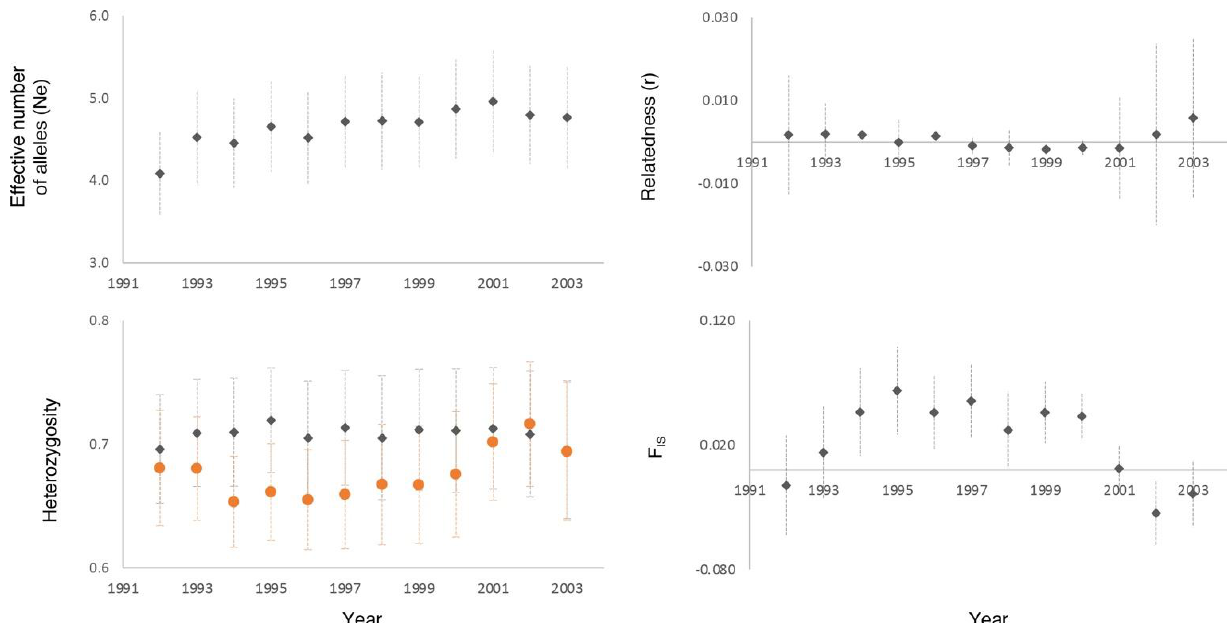
Figure 2. Genetic diversity over time, based on 17 microsatellite loci. The effective number of alleles ( Ne , top-left panel), observed heterozygosity ( H O , bottom-left panel, orange circles) and expected heterozygosity ( H E , bottom-left panel, gray triangles), and relatedness ( r , top-right panel) are constant over time. Wright’s inbreeding coefficient ( F IS , lower-right panel) shows a significant deficiency of heterozygotes (positive F IS ) during the years 1994–2000.